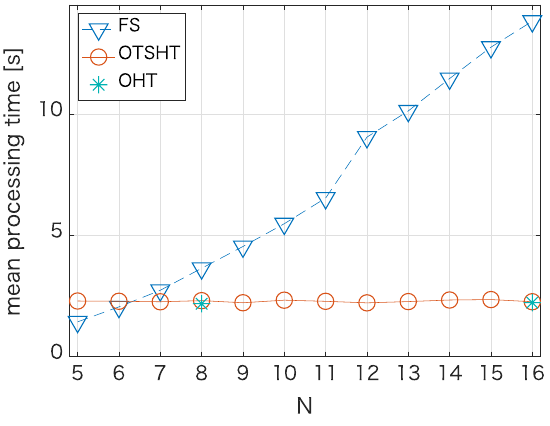
Figure 10. Mean processing time of OTSHT vs. FS. 100 templates are used for evaluation.